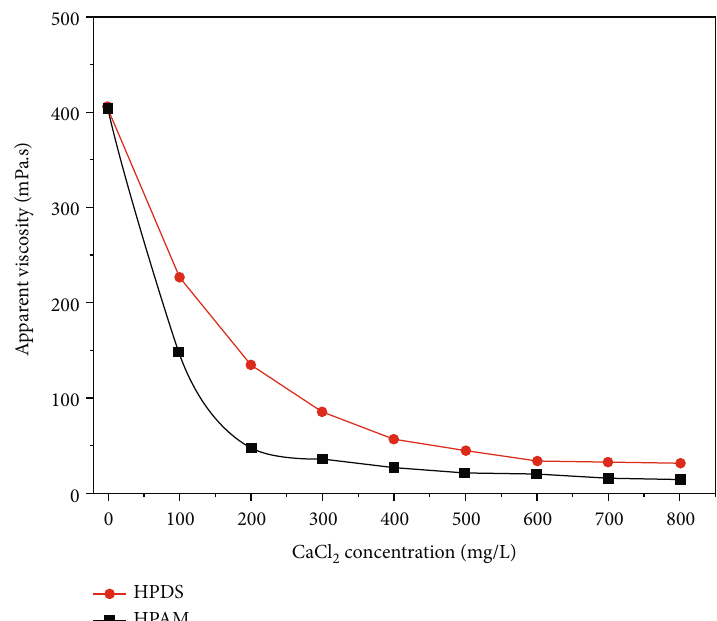
Figure 11: E ff ect of CaCl concentration on apparent viscosity of polymer aqueous solution. The apparent viscosity was tested by Brook fi eld 2 DV-III rheometer at 7.34s − 1 .